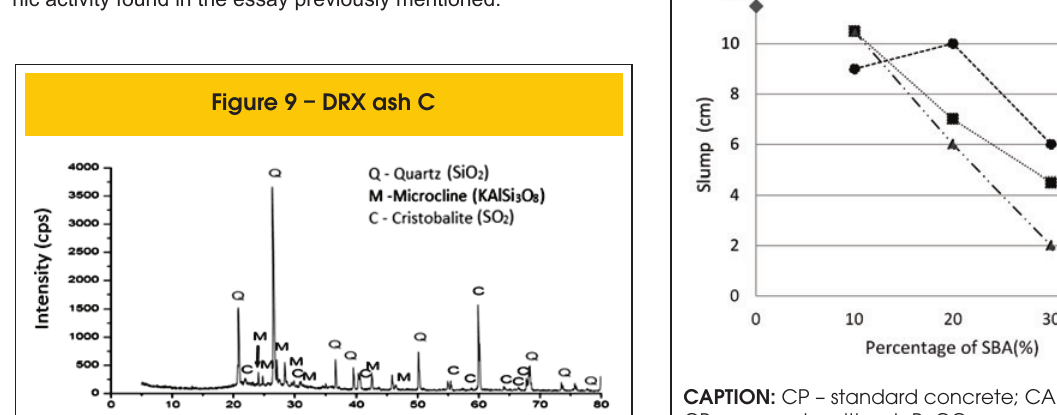
Figure 11 – Subsidence of the trunk cone of the